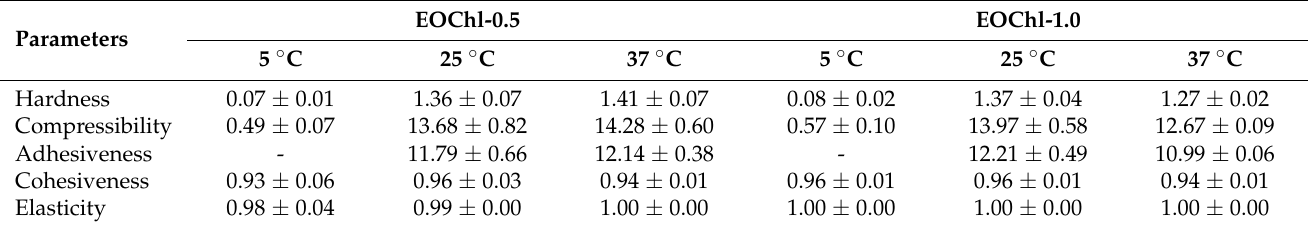
Table 2. Mechanical properties—hardness (N), compressibility (N · mm), adhesiveness (N · mm), elas- ticity (dimensionless), and cohesiveness (dimensionless)—of formulations at different temperatures.